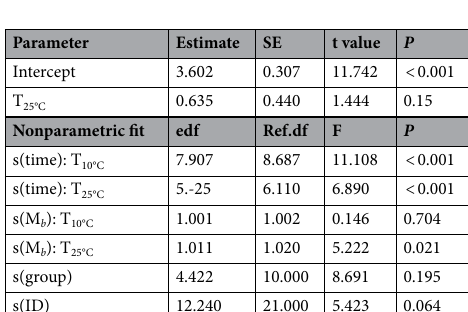
Figure 2. Modelled ΔT of male bats in the two treatments. Data are shown in relation to ( A ) time and ( B ) body mass (M b )both grouped by treatment (T 25°C in black and T 10°C in grey). Thinner lines represent 95% confidential intervals (CI). Asterisks indicate significant effects.